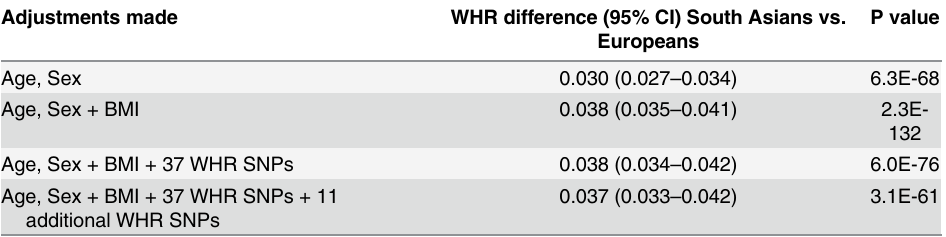
Table 2. Multivariate regression analysis of waist hip ratio in South Asian compared to European par- ticipants in the LOLIPOP